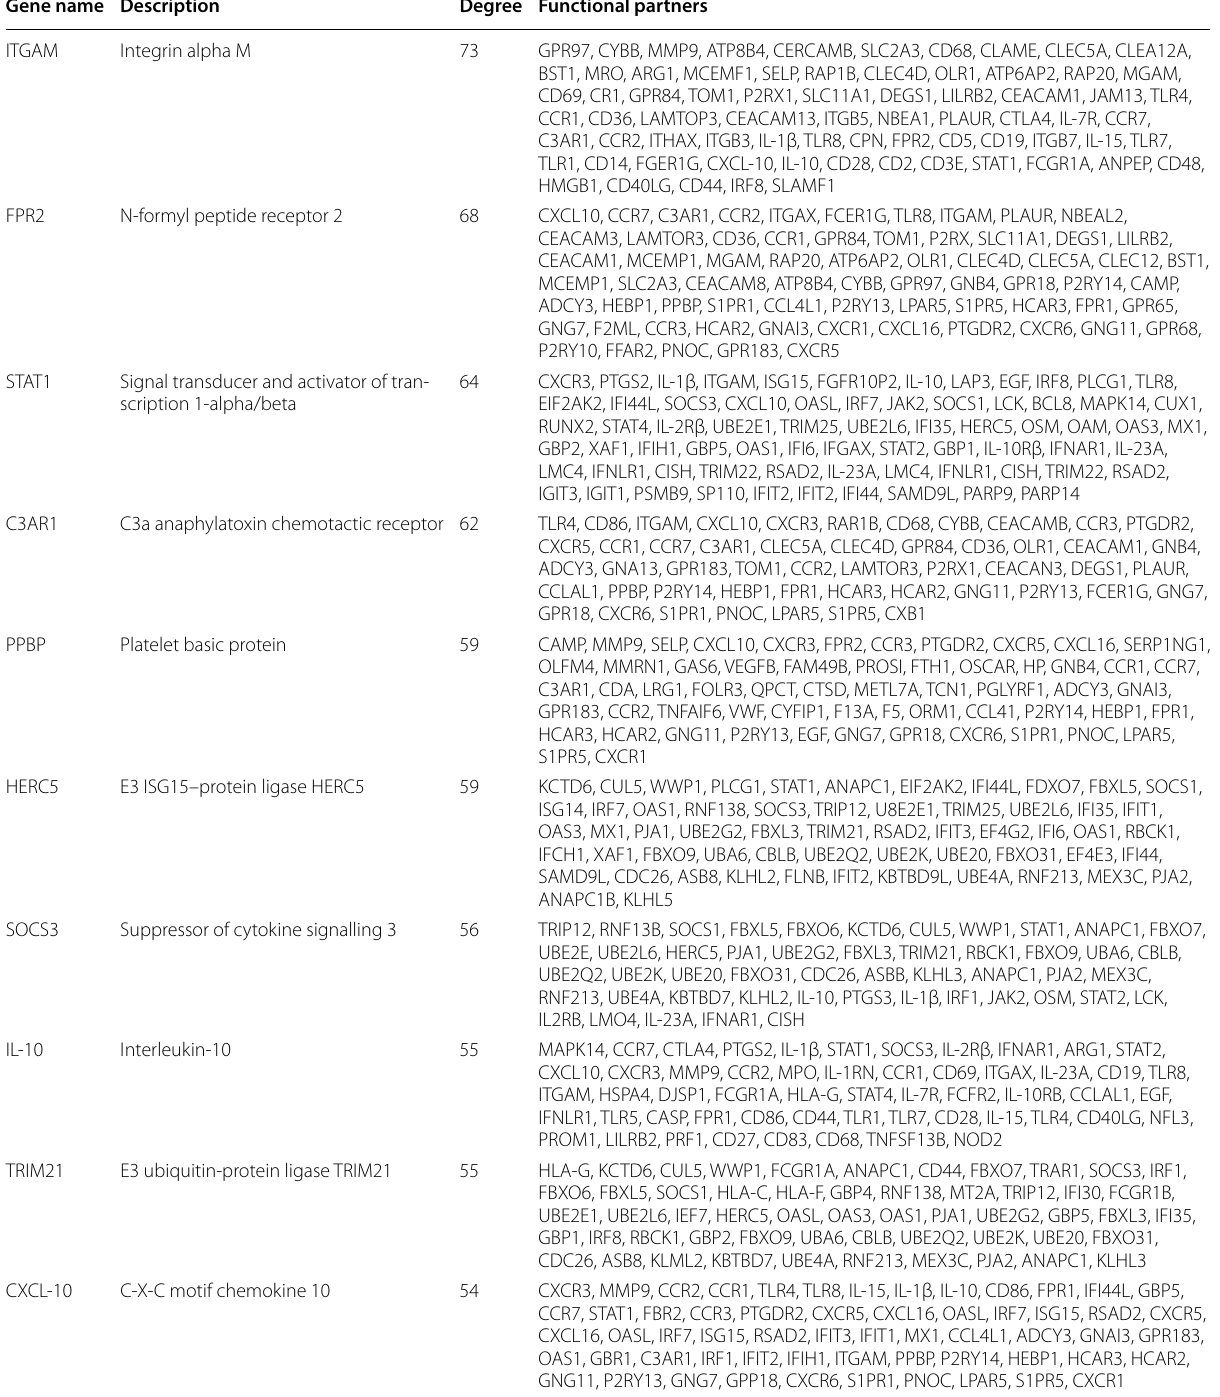
Table 2 List of top 10 genes with a greater number of functional interactors in the gene interaction network of DEGs in T2DM-TB Gene name